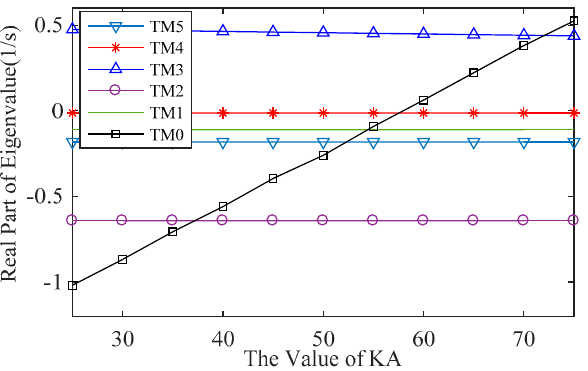
Figure 7. Influence of excitation system parameters on SSR characteristics.